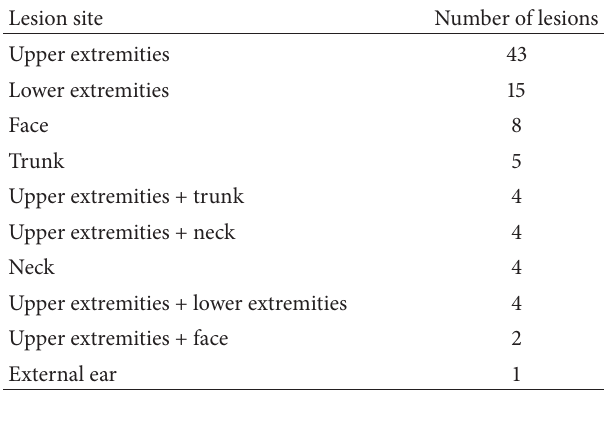
Table 1: Distribution of scar sites.